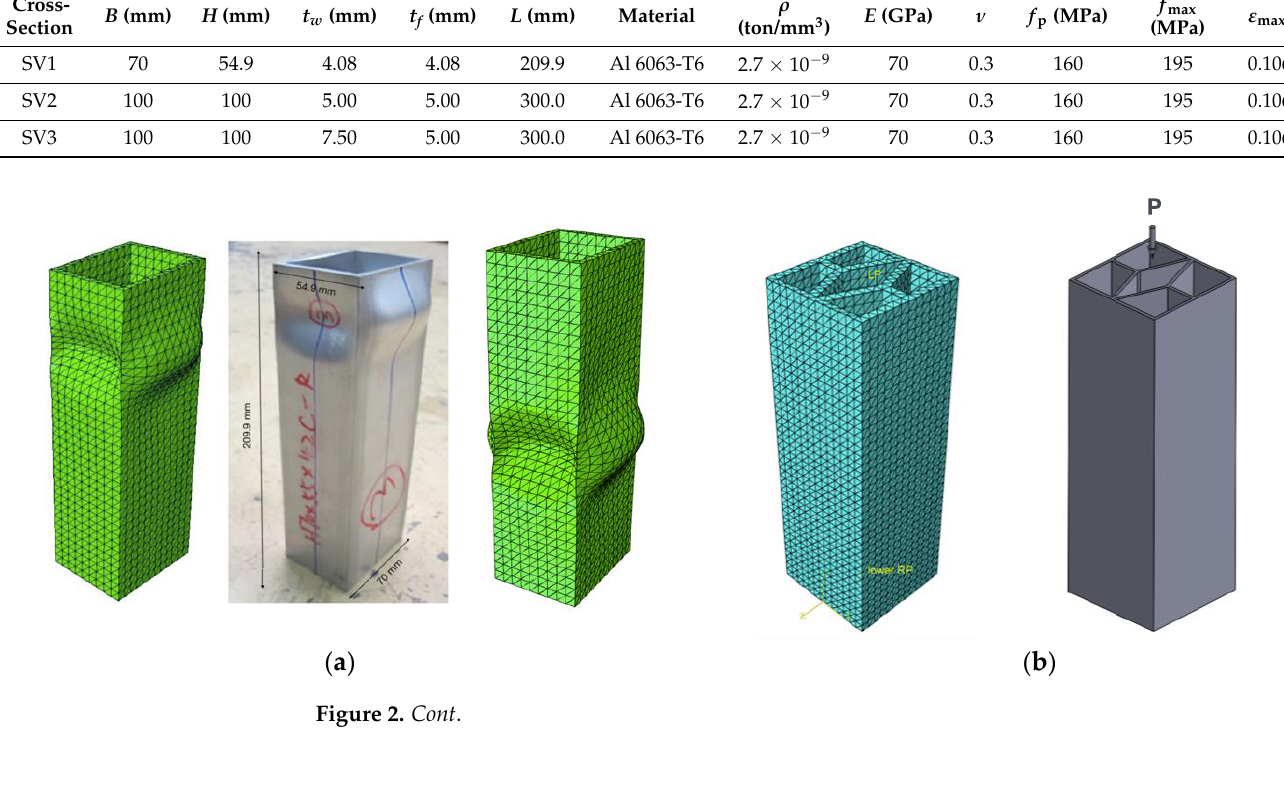
( c ) ( d ) Figure 2. Validation analyses: ( a ) rectangular H70 × 55 × 4.2C-R cross-section [1] ( left ), SV1 ( right ); ( b ) mesh, load, and boundary conditions (same across all models); ( c ) S1 optimised cross-section [1] ( left ), SV2 ( right ); ( d ) S2 optimised cross-section [1] ( left ), SV3 ( right ).